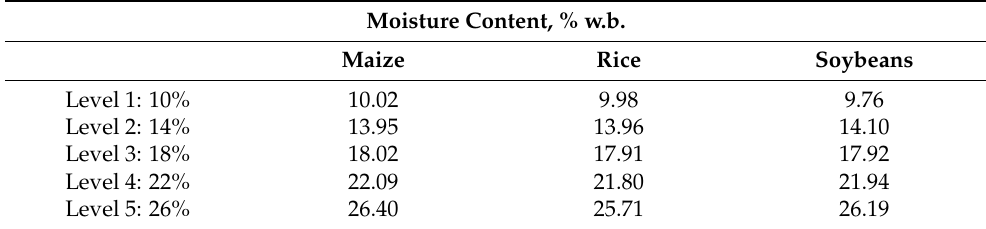
Table 1. Moisture content of cereal grains after conditioning to predetermined levels. Moisture Content, %